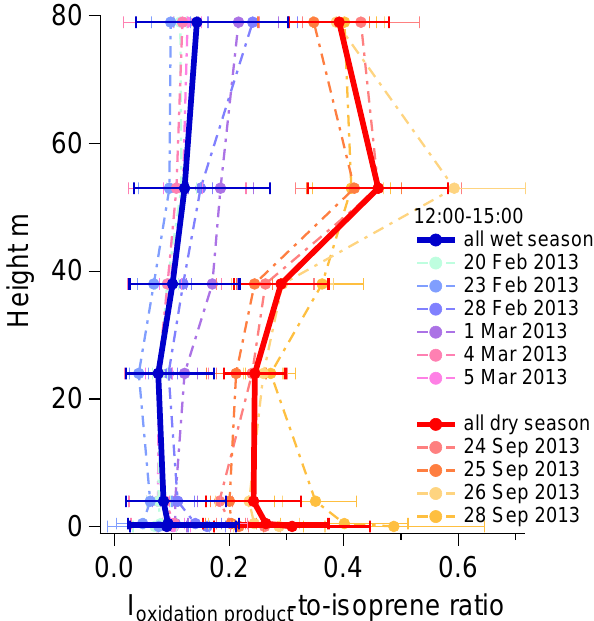
Figure 7. Average profiles of the isoprene oxidation product (I oxidationproducts )-to-isoprene ratio for the dry and wet season for the period of 12:00–15:00LT for the whole measurement period (thick lines) and as single day analysis (dashed